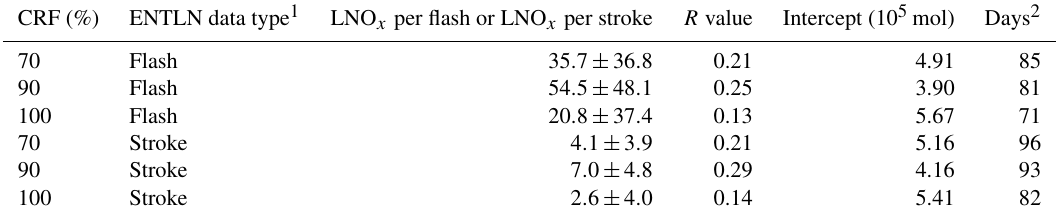
Table 3. LNO x production efficiencies for different thresholds of CRF with coincident ENTLN data, TL ≥ 1000, and ratio ≥ 50%.